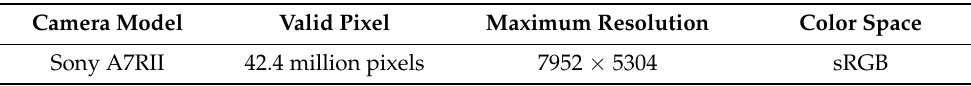
Table 1. The parameters of